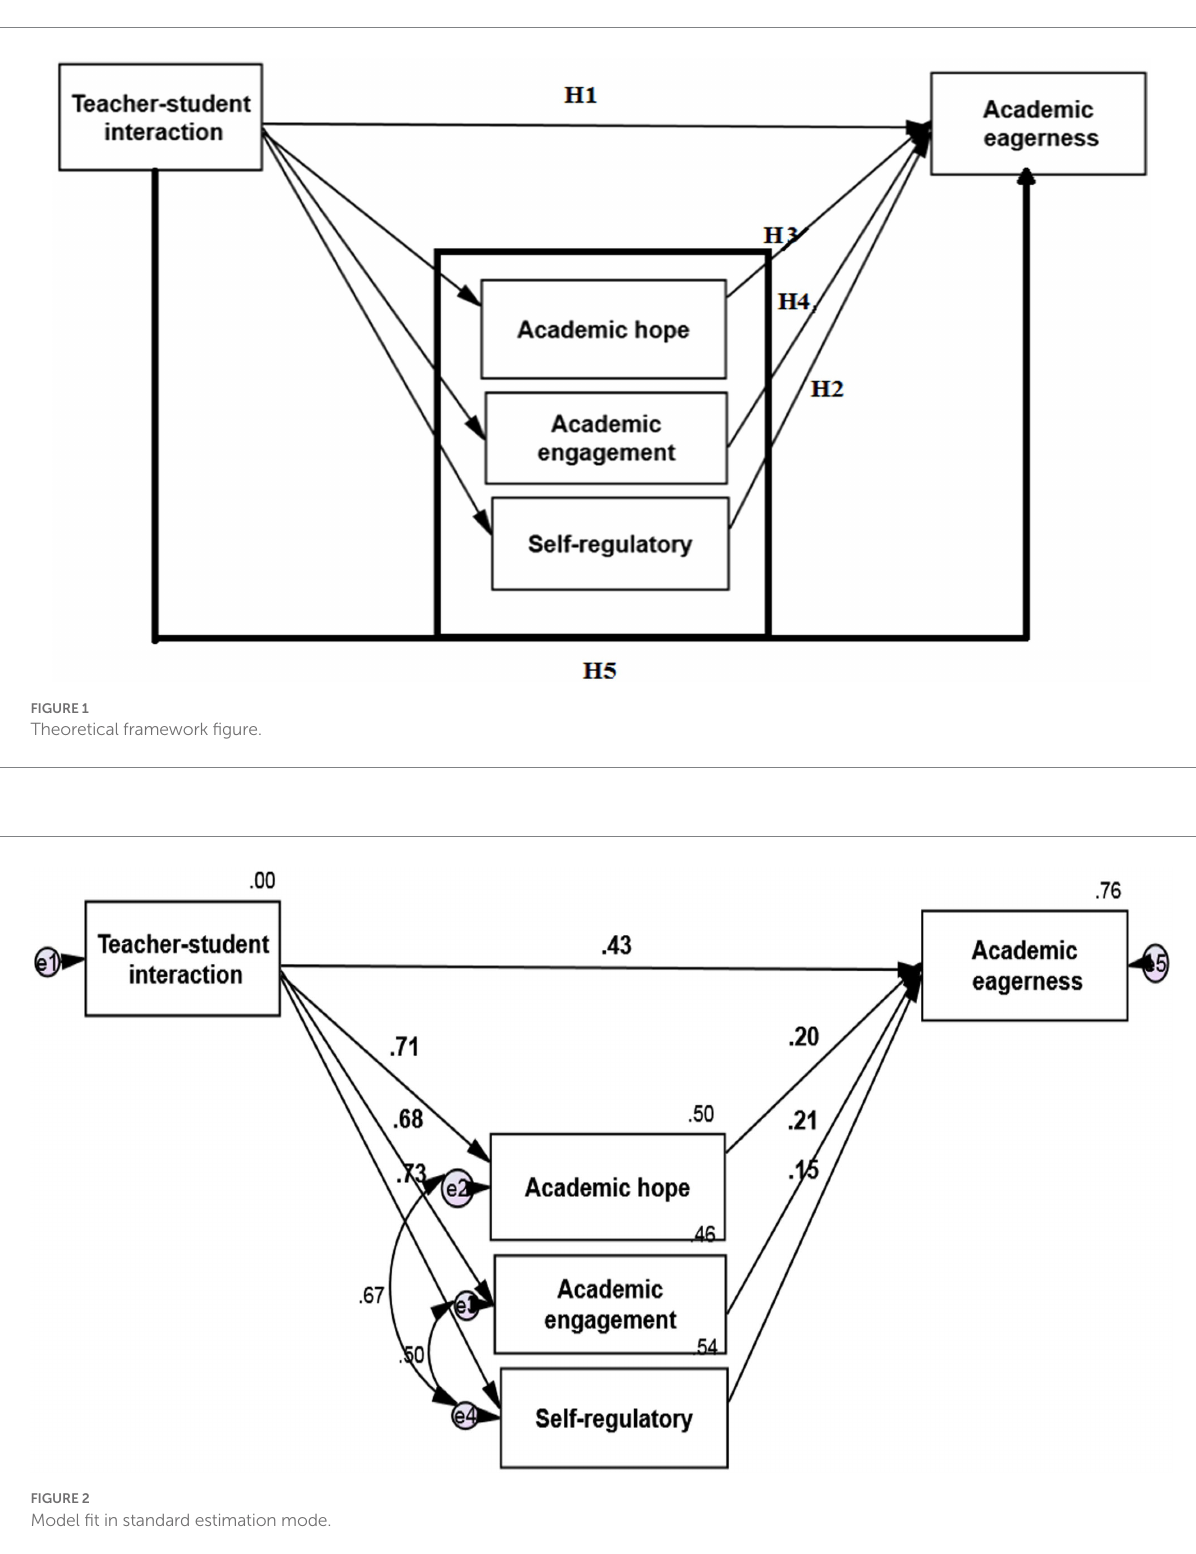
English students’ academic enthusiasm is 0.428. According to the absolute value of t-test statistics which is equal to 10.810 and greater than 1.96, it can be concluded with a 99% probability of